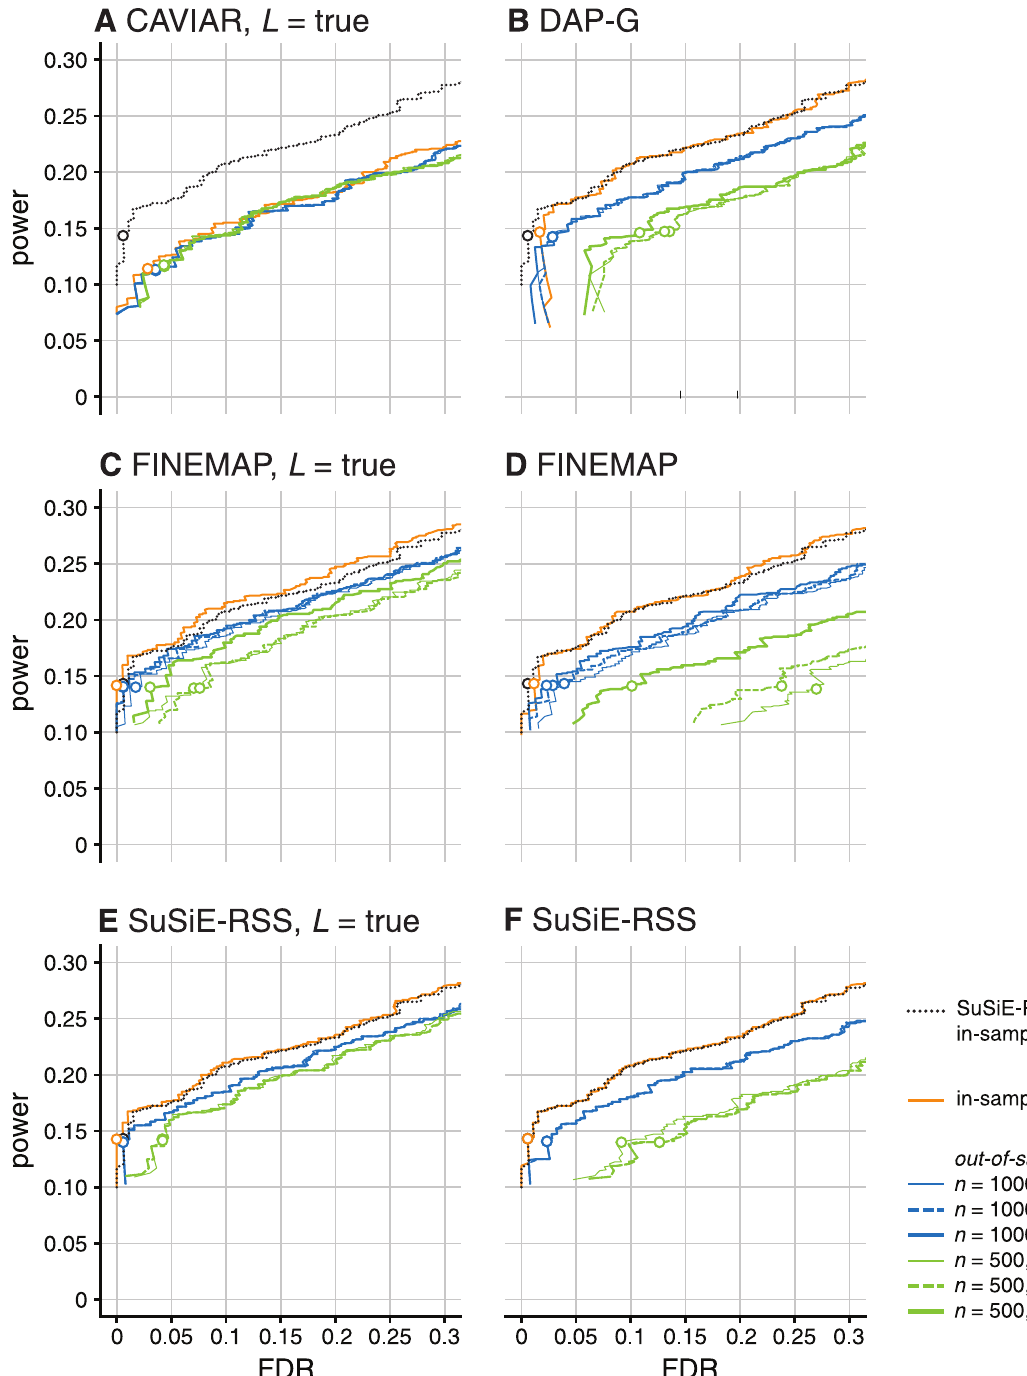
Fig 5. Discovery of causal SNPs using posterior inclusion probabilities—Out-of-sample LD. Plots compare power vs. FDR for fine-mapping methods with different LD matrices, across all 600 simulations, as the PIP threshold is varied from 0 to 1. Open circles indicate results at PIP threshold of 0.95. Each plot compares performance of one method (CAVIAR, DAP-G, FINEMAP or SuSiE-RSS ) when provided with different LD estimates: in-sample ( ^ R ¼ R ), or out-of-sample LD from a reference panel with either 1,000 samples ( ^ R ¼ ^ R For out-of-sample LD, different levels of the regularization parameter λ are also compared: λ = 0; λ = 0.001; and estimated λ . Panels C–F show results for two variants of FINEMAP and SuSiE-RSS : in Panels C and E, the maximum number of causal SNPs, L , is set to the true value (“ L = true”); in Panels D and F, L is set larger than the true value ( L = 5 for FINEMAP; L = 10 for SuSiE-RSS ). In each panel, the dotted black line shows the results from SuSiE-RSS with in-sample LD and estimated σ 2 , which provides a baseline for comparison (note that all the other SuSiE-RSS